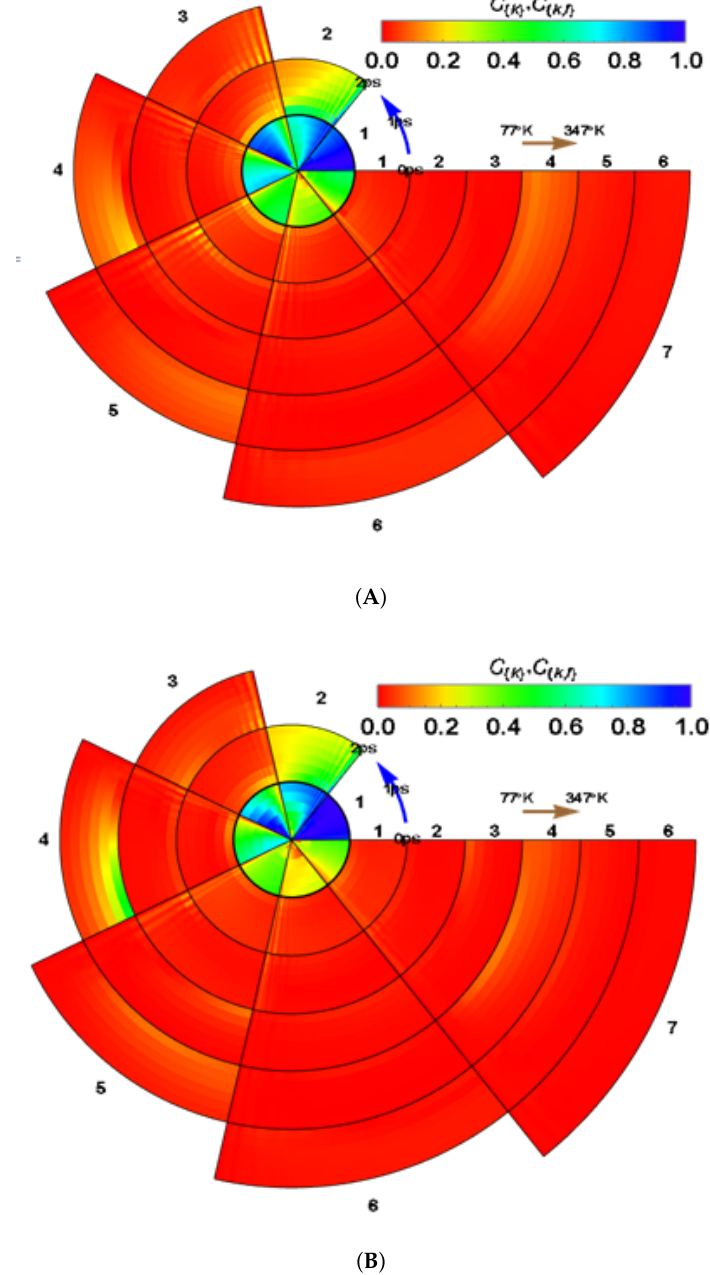
Figure 11. Entanglement color chart for γ k = 50cm − 1 with ( A ) λ k = 35cm − 1 , and ( B ) λ k = 65cm − 1 . In the center, concurrence C { k } evolution for each BChl, and in the outer tracks C { kl } between different pairs in the crossing of each circular track and each angular sector. Time grows counterclockwise in [ 0,2 ] ps on each angular sector. Temperature grows radially outwards on each track in [ 77,347 ] ◦